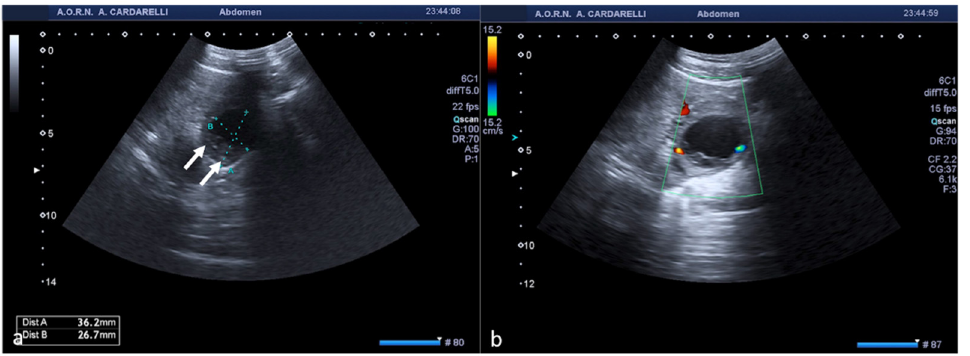
Figure 3. Haemorrhagic left ovarian cyst. Axial TSA-US image ( a ) shows a hemorrhagic corpus luteum (( a ) caliper) with blood deposits (( a ) arrows). On colour-Doppler imaging ( b ) circumferential blood flow is also shown.